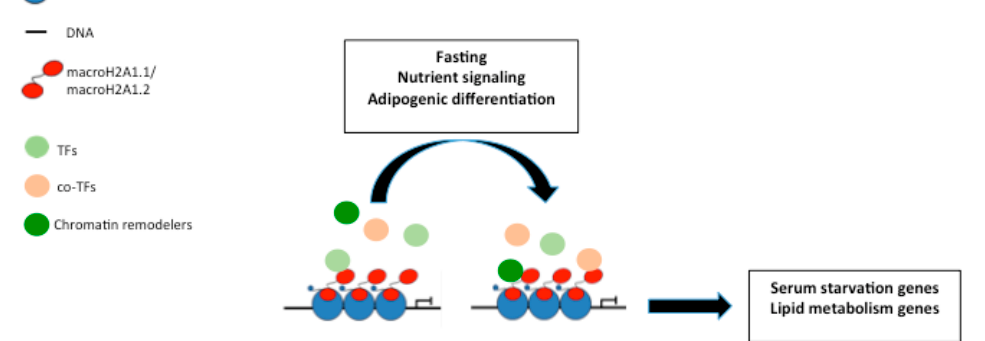
Figure 2. MacroH2A1-dependent integration of nutritional inputs into gene expression programs. This occurs in a fashion that seems independent of changes in its genome occupancy but might require the interaction with yet-to-be identified transcriptional factors (TFs), co-factors and chromatin remodelers (see text for details).